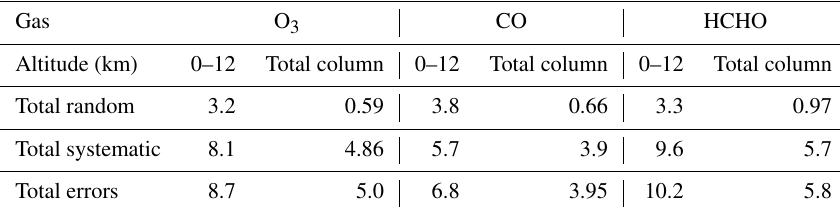
Table 3. Errors in % of the column amount of O 3 , CO, and HCHO for the 0–12km tropospheric partial column and for the total column. Gas O 3 CO HCHO Altitude (km) 0–12 Total